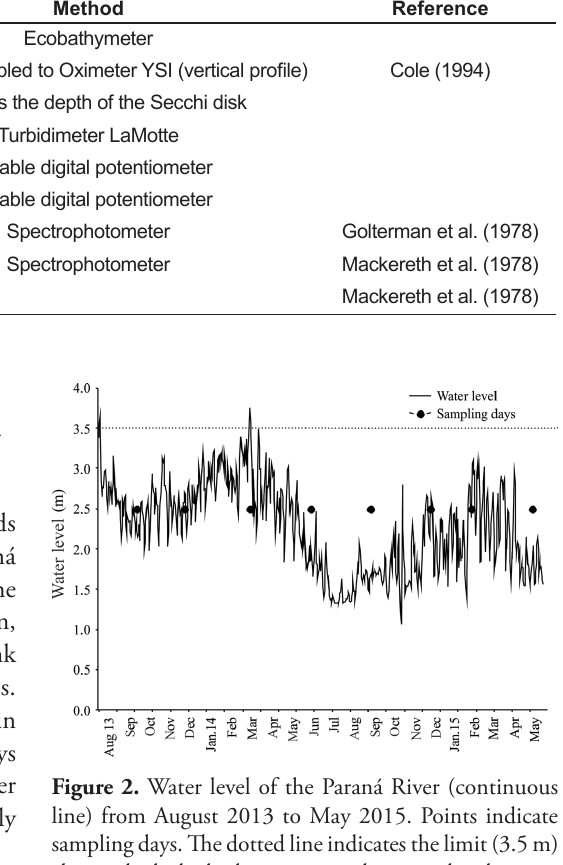
Table 1. Methodologies used to determine water physical and chemical parameters.